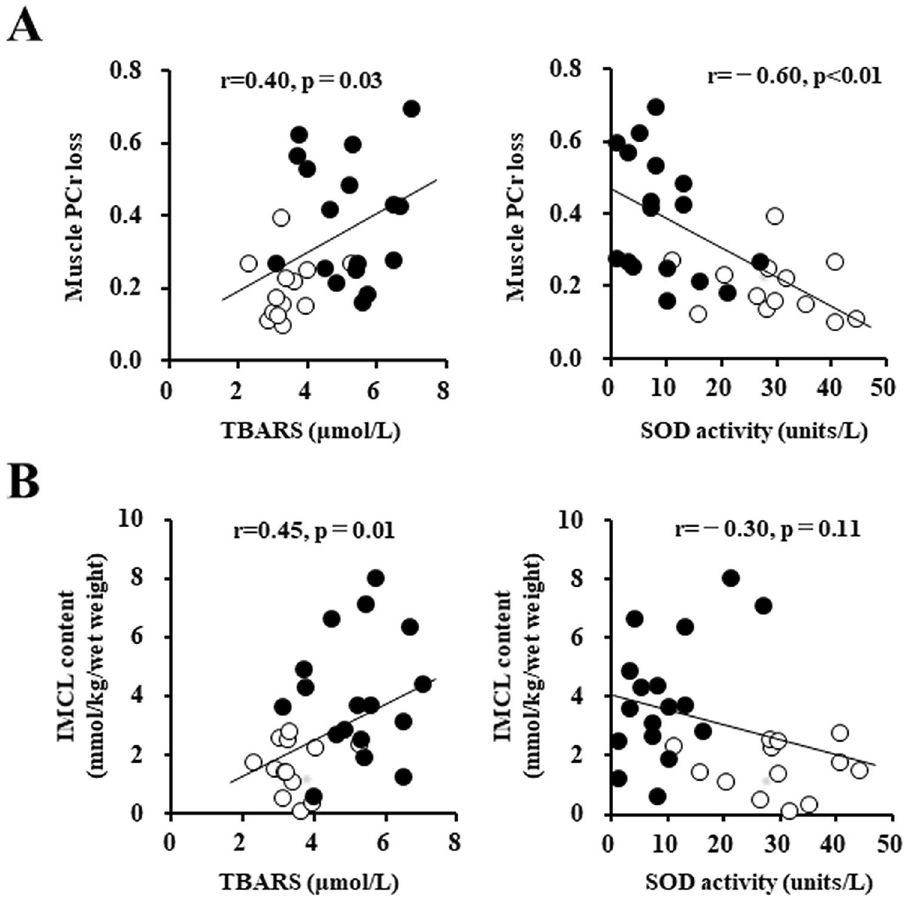
Figure 3. Linear relationship between systemic oxidative stress and skeletal muscle energy metabolism. ( A ) Systemic oxidative stress and muscle PCr loss during the plantar-flexion exercise and ( B ) systemic oxidative stress and IMCL content. White circles: Control subjects (n = 13). Black circles: CHF patients (n = 17). IMCL: intramyocellular lipid, PCr: